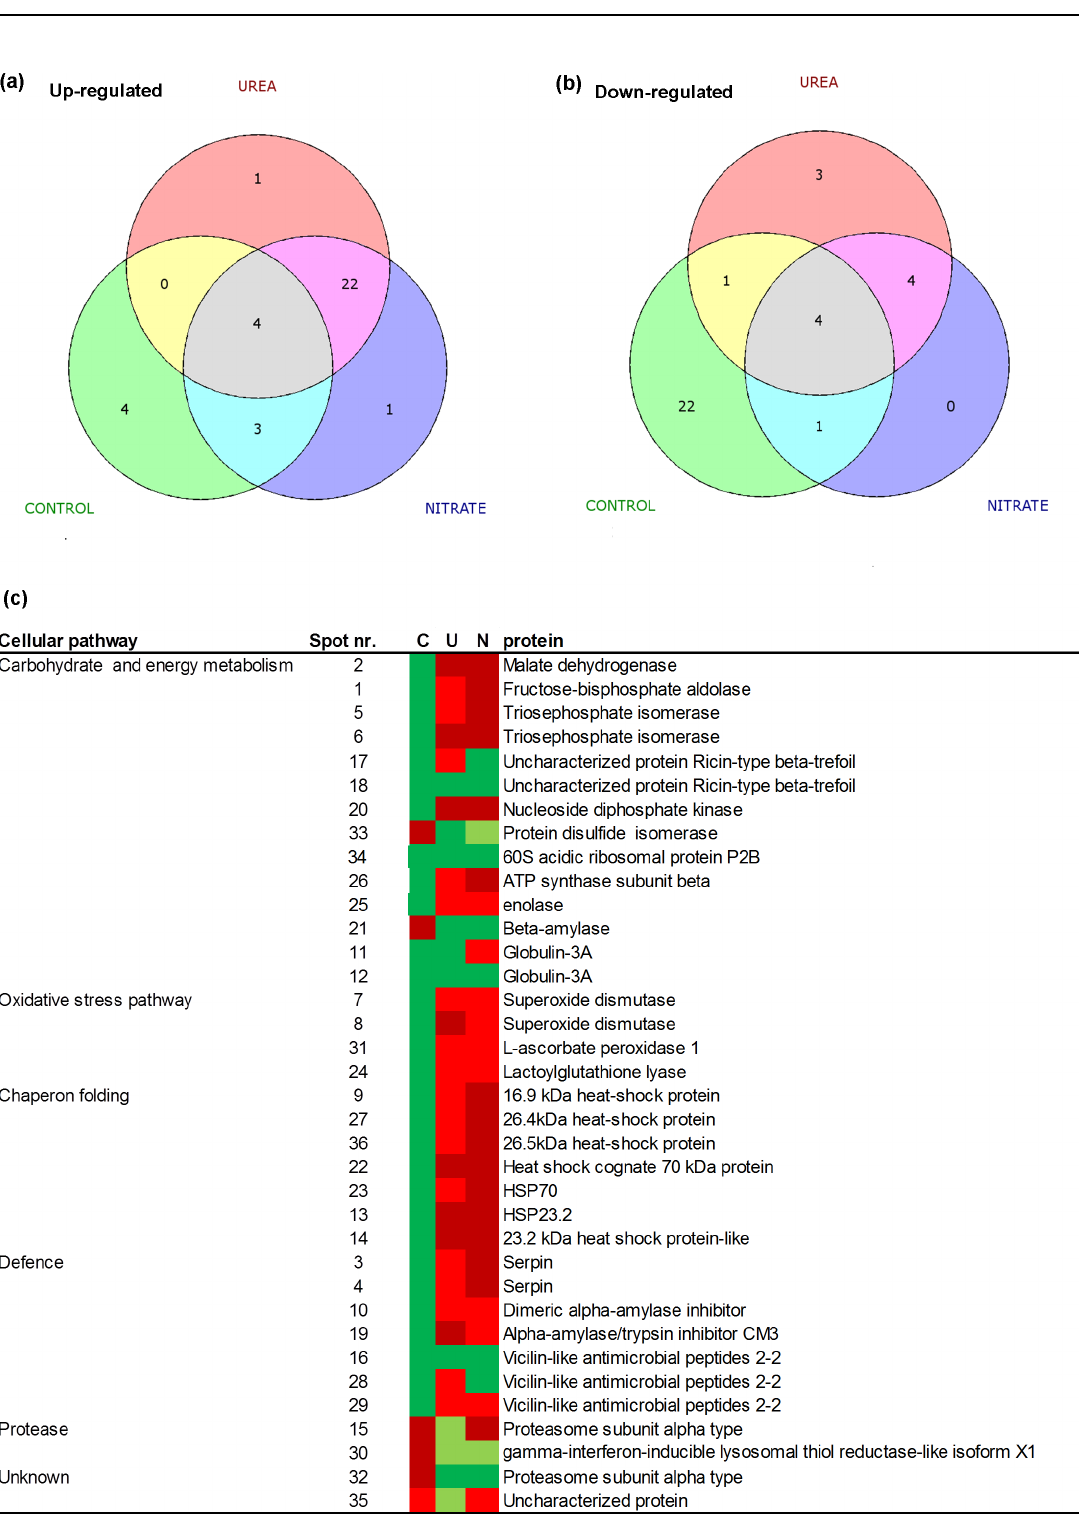
Fig 10. ESI-LC-MS/MS identification and differential abundance of proteins from durum wheat immature grains. (a) Venn diagram showing the number of unique proteins in the 15 and 13 DPA (in 2011 and 2012, respectively) phase of grain filling, which were up-regulated in the different treatments, (b) Venn diagram showing the number of unique proteins in the 15 DPA and 13 DPA (in 2011 and 2012, respectively) phase of grain filling, which were down-regulated in the different treatments, (c) Heat map showing protein abundance by UREA (U) and NITRATE (N) fertilization treatments compared with